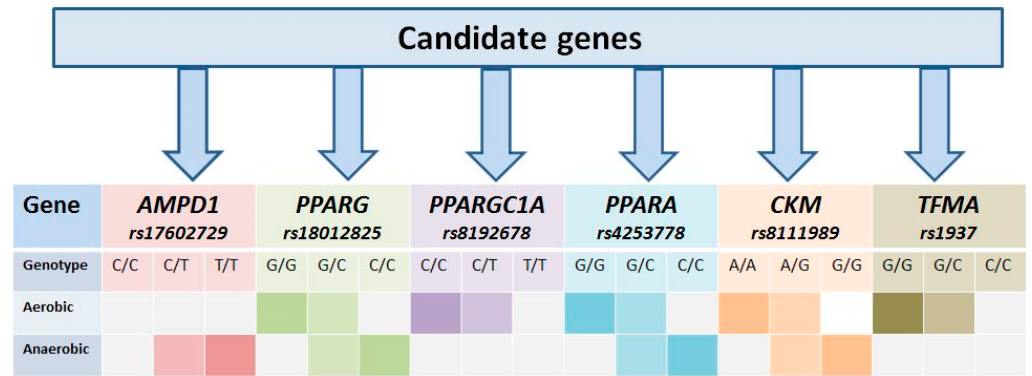
Figure 8. Personalized algorithm for determining the type of energy metabolism among athletes: The color saturation in squares corresponding to the variable genotypes of the candidate genes presented by SNVs demonstrates the best profile of energy metabolism of skeletal muscles and myocardium for anaerobic and aerobic sports.